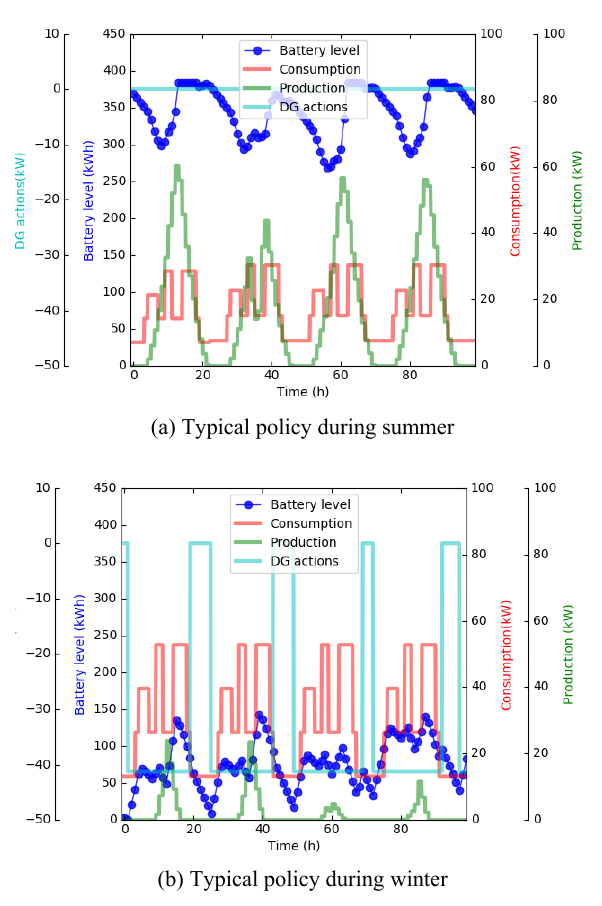
Fig. 15. Computed policy with extended information available to the agent. DG action = 0 means keeping it idle; DG action = - 40 means turning ON at 75% capacity (Prime Power Mode); DG action = -60 means turning ON at full capacity (Emergency Standby Power Mode).